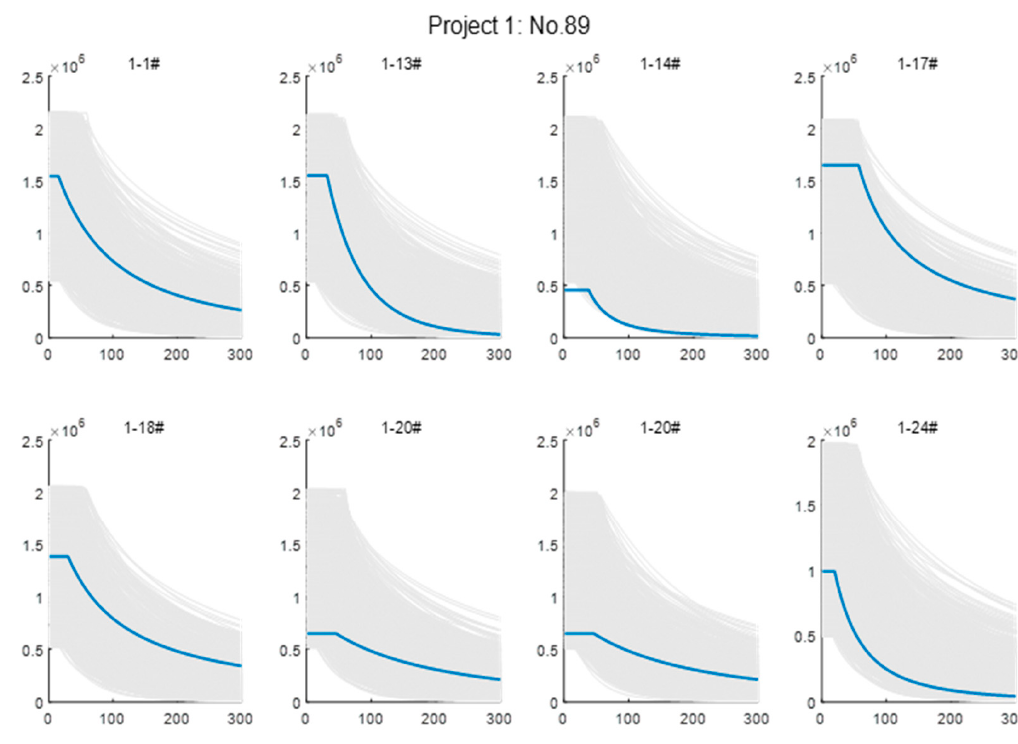
Figure 4. Production plan of project 1.